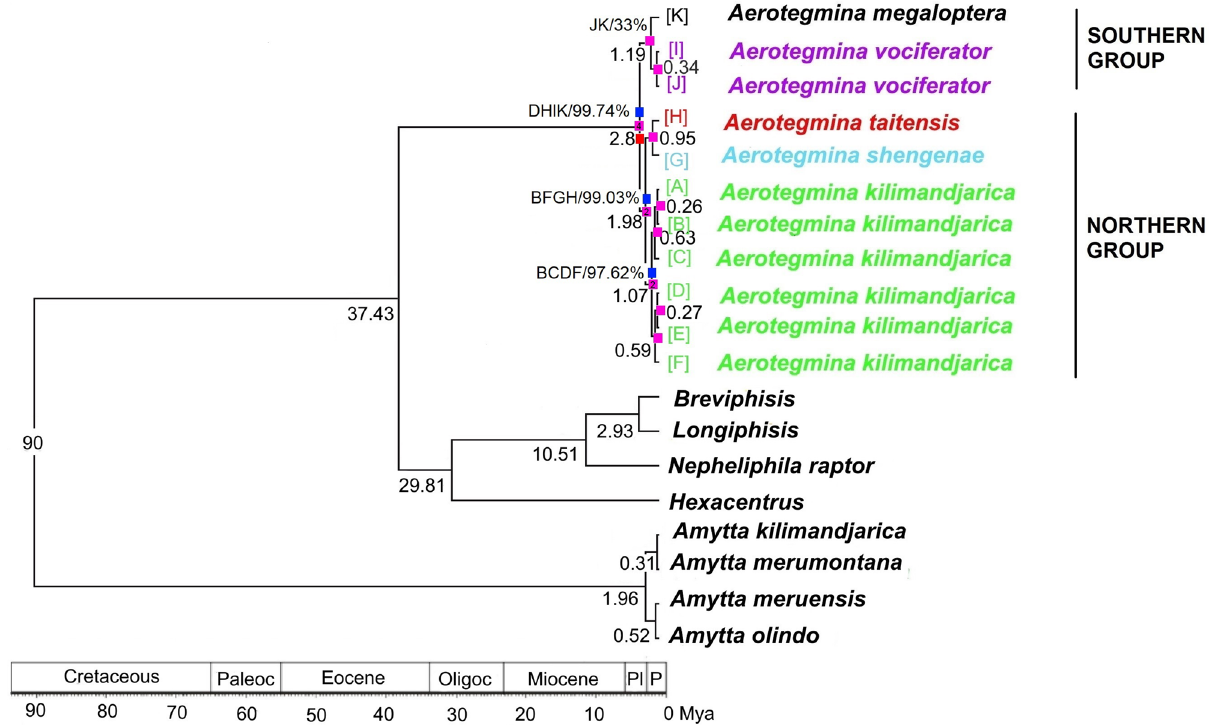
Figure 3. Reconstructed geographic ranges and dated phylogeny of Aerotegmina obtained through phylogenetic analysis using Beast software with a relaxed molecular clock model (Beast tree is given). The values indicated under the branches represent the mean ages of lineage divergence; acronyms on the nodes and at the tip labels indicate geographic areas: [A]—North Pare Mountains, [B]—Marang Forest, [C]—Mt. Kenya, [D]—Mt. Meru, [E]—Nou Forest, [F]—Mt. Kilimanjaro, [G]—South Pare Mountains, [H]—Taita Hills, [I]—Udzungwa Mountains, [J]—Nguru Mountains, [K]—Kazimzumbwi Forest Reserve (Kisarawe); the values above branches support the predicted distribution. The different colour squares on the branches close to the nodes represent different events: pink—vicariance, navy blue—dispersal and red—extinction; digit inside the square means how many events were at the node (showing only values greater than 1). Mya—million years ago, Paleoc—Paleocene, Oligoc—Oligocene, Pl—Pliocene and